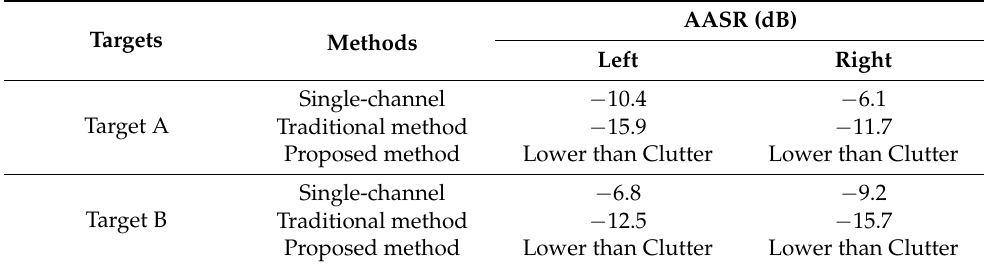
Table 4. The AASR of the targets in Figure 14.